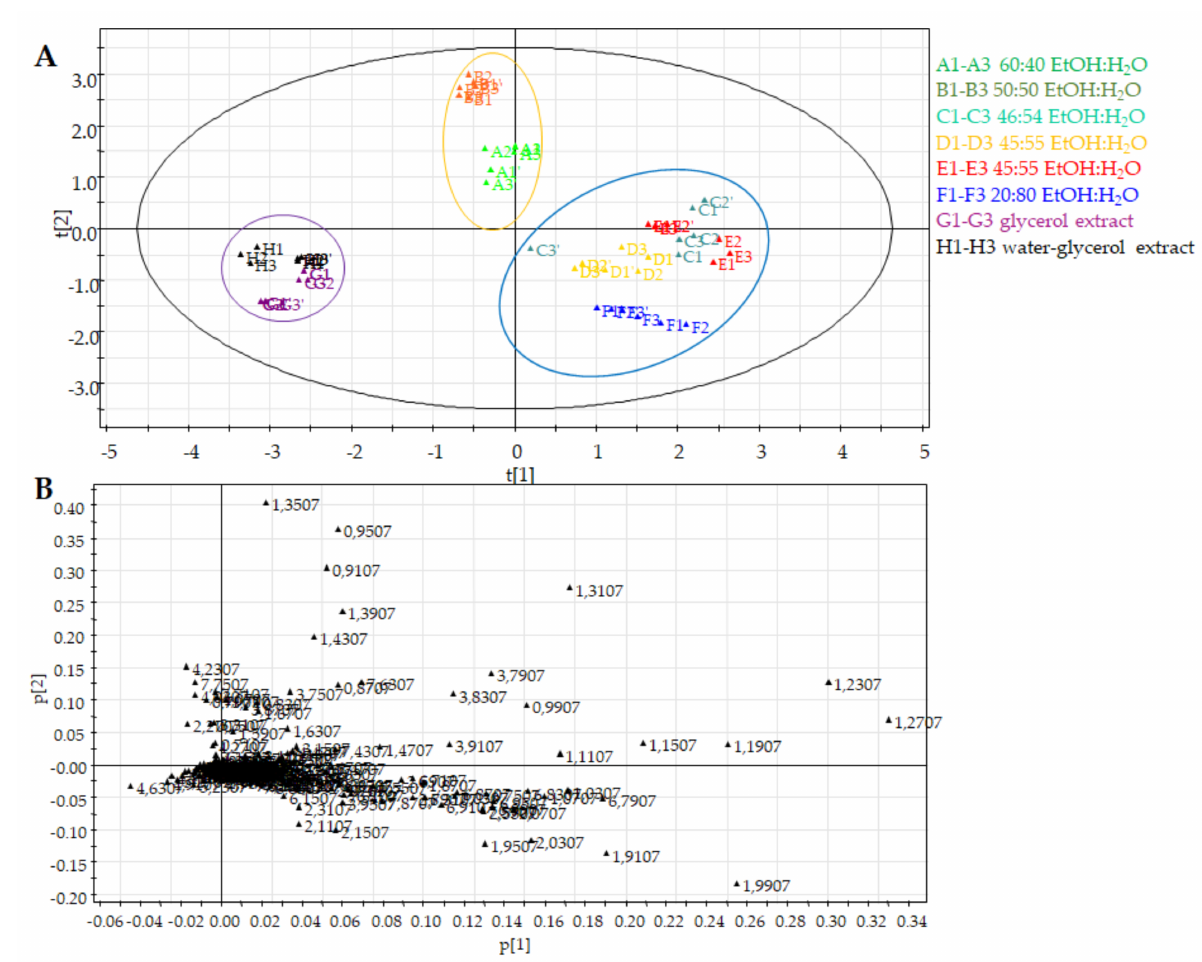
Figure 2. Principal component analysis of H. italicum derived food supplements ( A : 60:40; B : 50:50; C : 46:54; D and E : 45:55; F : 20:80 EtOH-H 2 O extracts; G : glycerol extract; H : water-glycerol extract) obtained by untargeted analysis. ( A ) PCA score scatter plot; ( B ) PCA loading